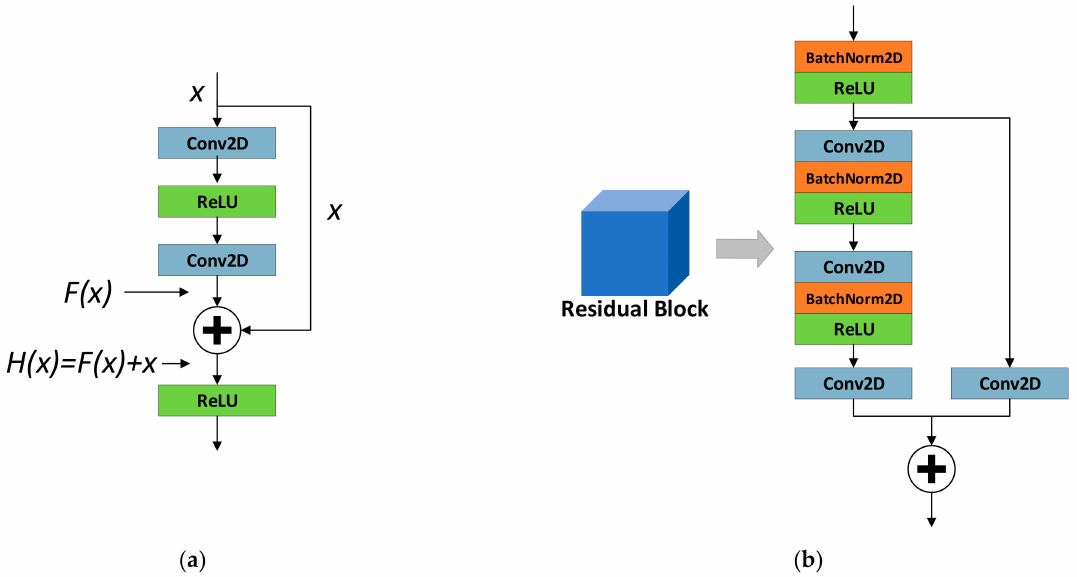
Figure 10. ( a ) Typical structure of the residual block, ( b ) residual block with additional convolution.